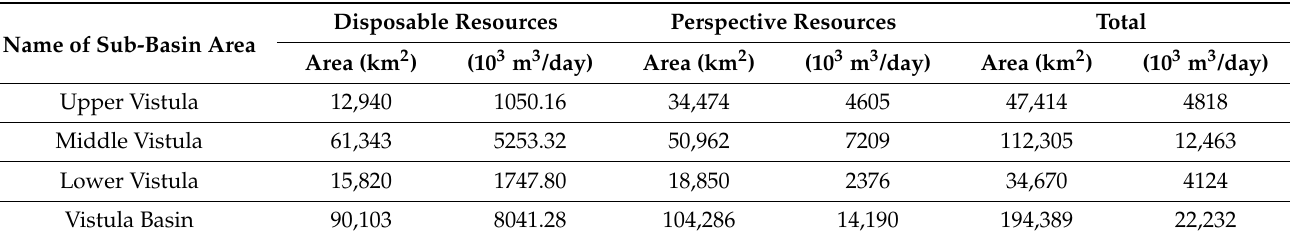
Table 3. Available and prospective groundwater resources in the Vistula basin